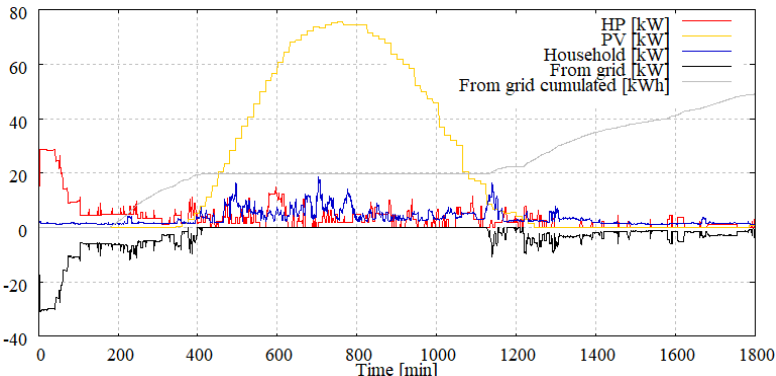
Figure 9. Cluster electrical demand with